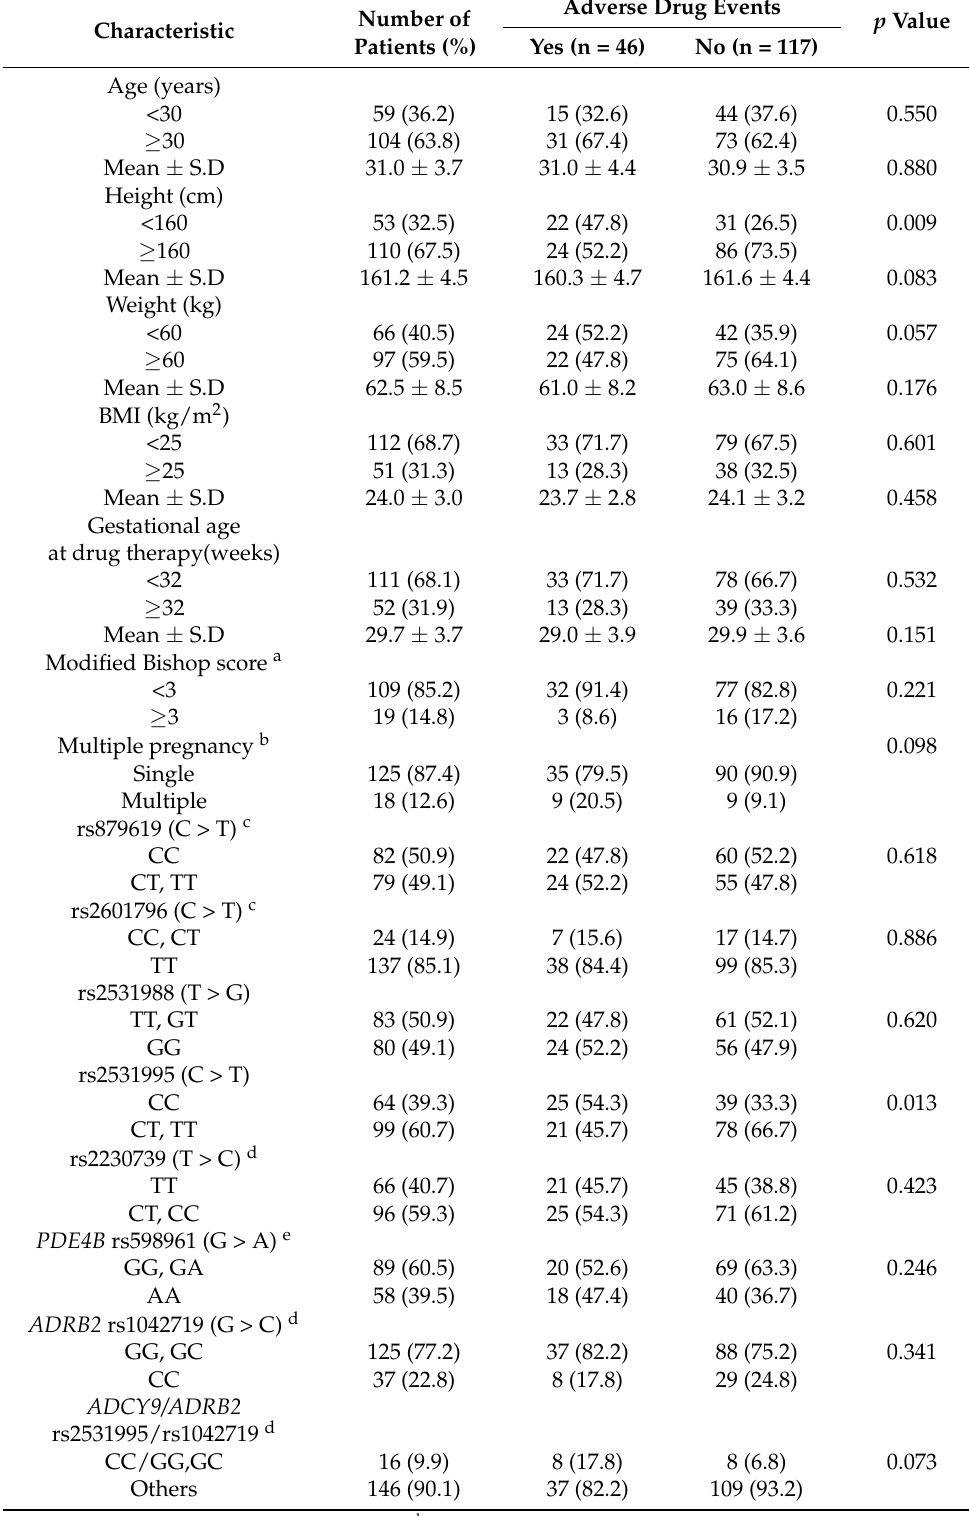
Table 4. Effects of demographic characteristics and grouped genotypes in ADCY9 on adverse drug